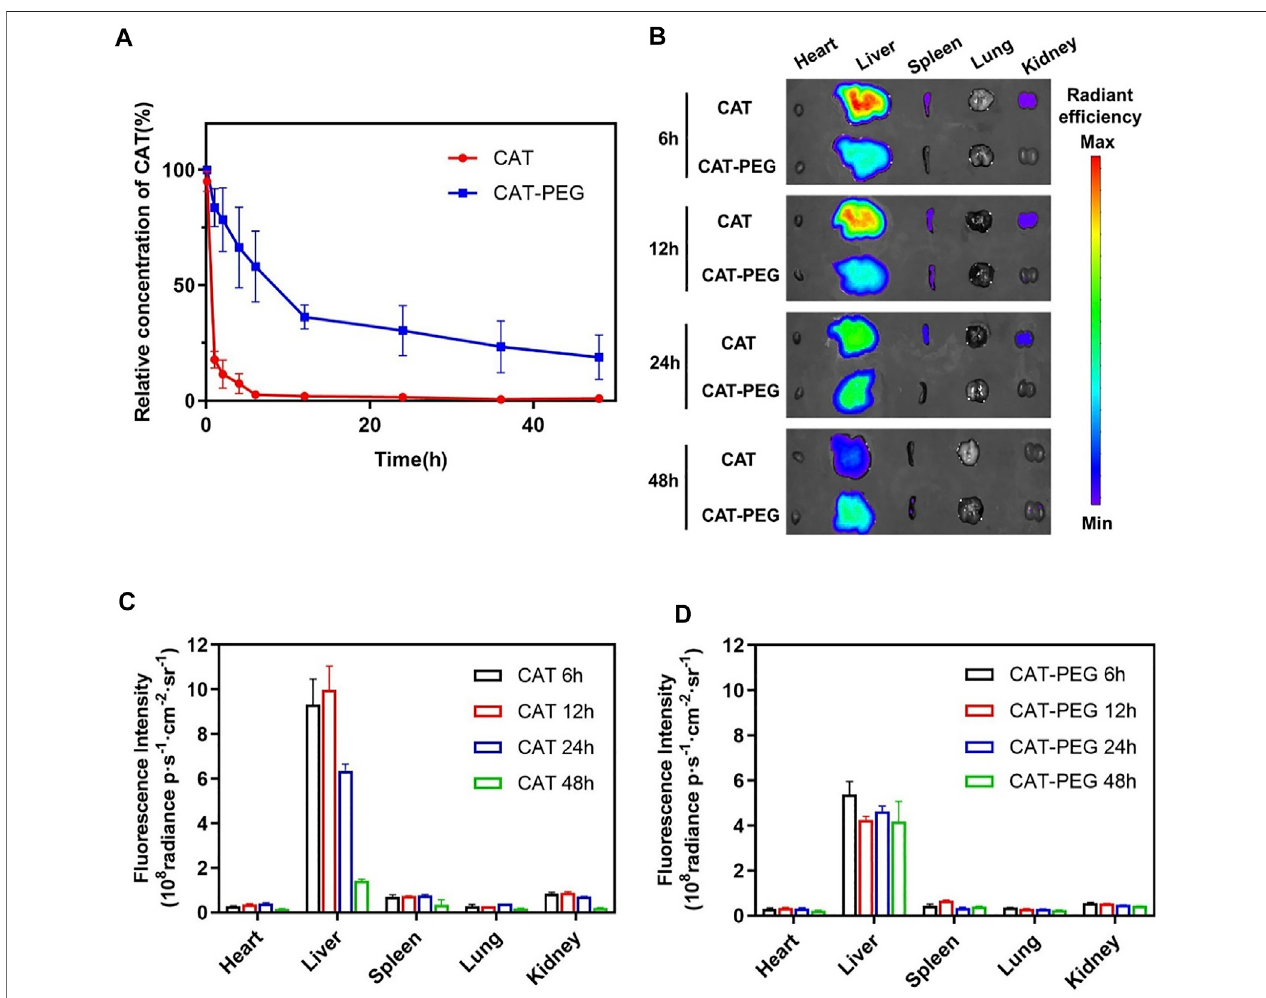
FIGURE3| PharmacokineticsandbiodistributionofCATandCAT-PEG. (A) PharmacokineticsofCATandCAT-PEGafterintravenousadministrationof5 mg/kg − 1 CAT or CAT-PEG. (B) Fluorescence imaging of the major organs after intravenous administration of 5 mg/kg − 1 sulfo-Cy7-labeled CAT or CAT-PEG. (C, D) Quantitative analysisoftheaccumulationofCAT(C)andCAT-PEG(D)intheorgans. n (cid:2) 3.Datarepresentmeans ± s.e.m.PharmacokineticsandbiodistributionofCAT-PEGinmice.